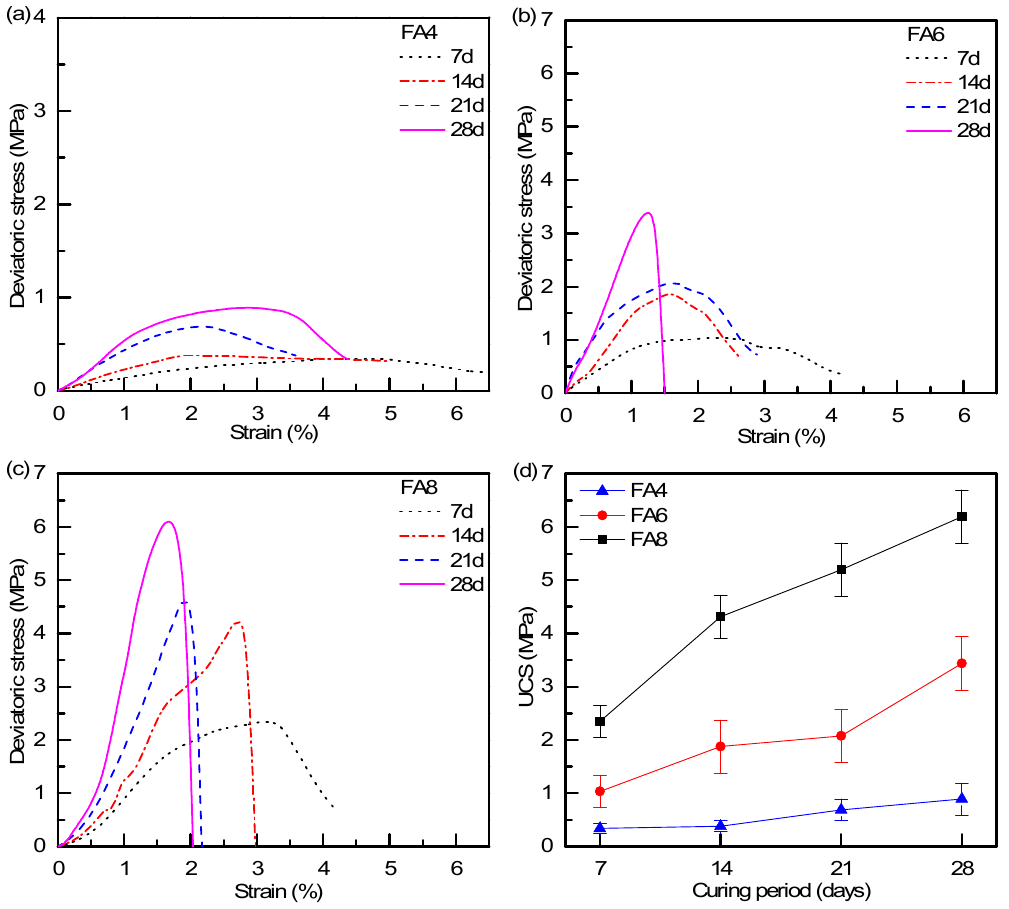
Figure 5. The stress-strain curves of ( a ) FA4; ( b ) FA6; and ( c ) FA8; and ( d ) the unconfined compressive strength at different curing periods.